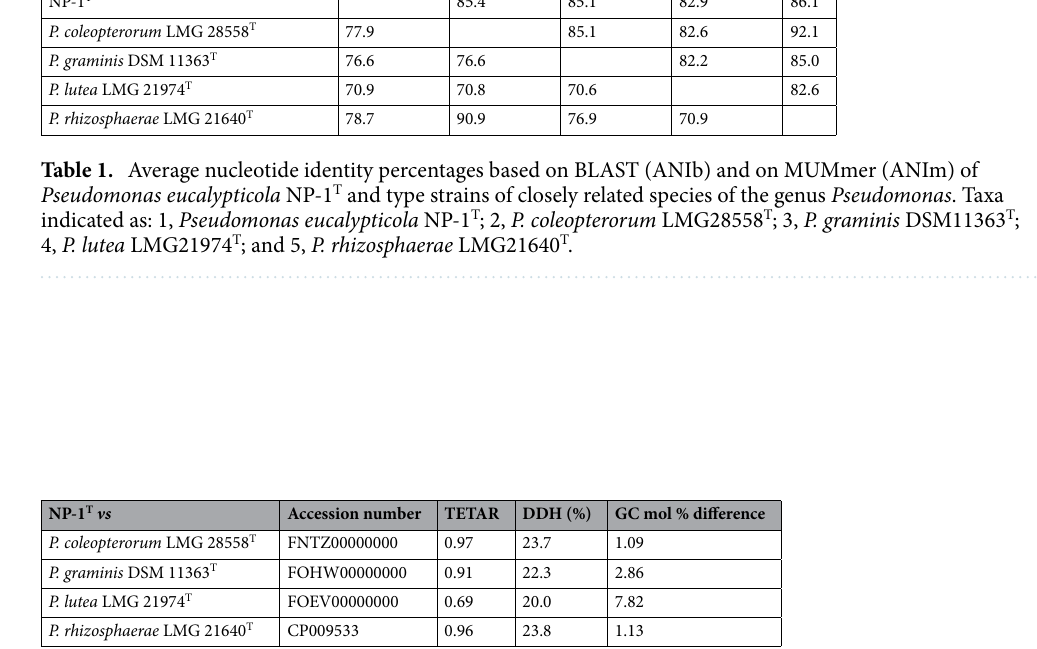
Table 2. Genome-based DDH and GC mol % difference between Pseudomonas eucalypticola NP-1 T and the type strains of closely related Pseudomonas species.